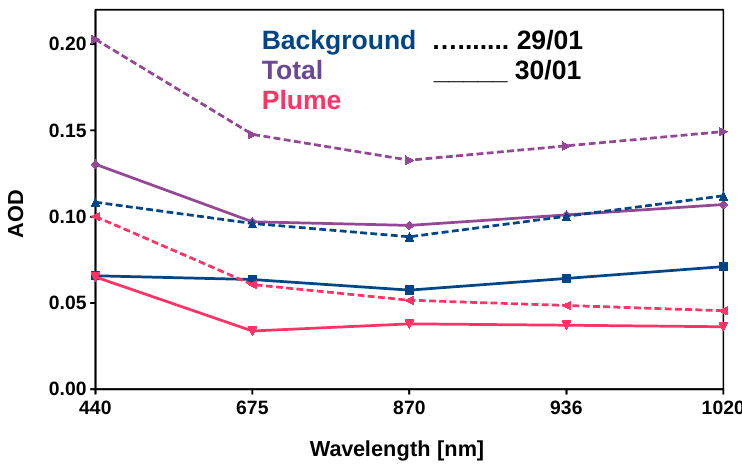
Figure 3. Spectral average MIISP AODs for background (blue symbols and lines) and total atmosphere (violet symbols and lines), and isolated volcanic plume (red symbols and lines), for 29 January (dotted lines) and 30 January (solid lines).